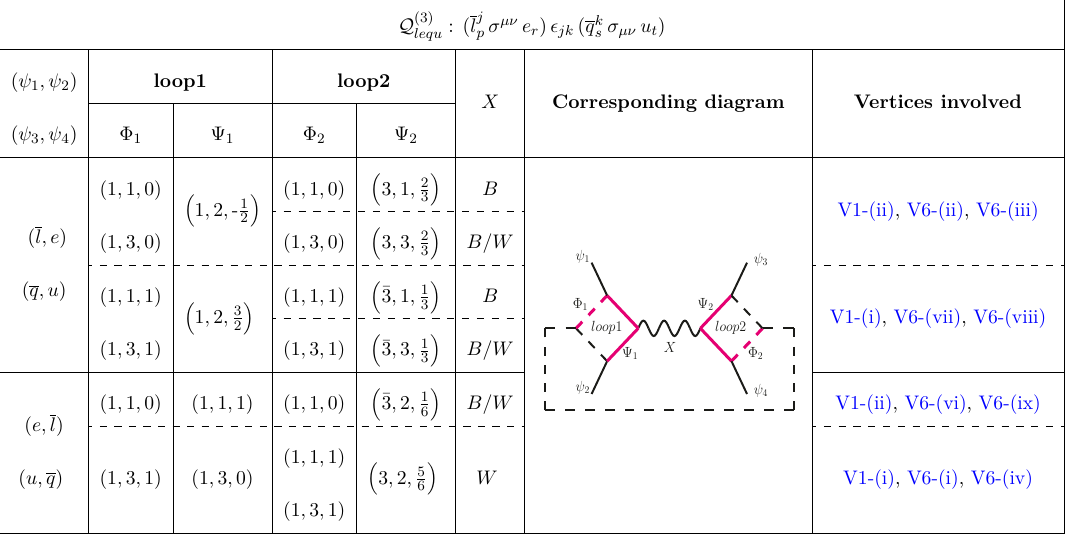
Table 22 . Combinations of heavy field representations that appear within the loops when the operator Q (3) is unfolded into a multi-loop diagram. The different orientations of the external legs lequ and the choice of the intermediate vector boson have been considered separately and the vertices have been listed for individual cases. Table 23 . List of dimension-6 SMEFT operators which receive non-zero contributions from the (cid:1) based on the diagrammatic unfolding of the operators. Also listed scalar lepto-quark (cid:0) 3 , 2 , 1 6